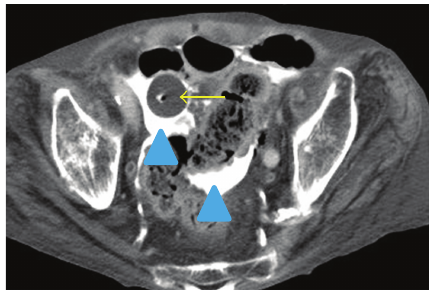
Figure 2: Contrast-enhanced computed tomography after transurethral perfusion of contrast medium demonstrated extravasation of the contrast material into the peritoneal cavity ( 󳵳 ). In addition, the Foley catheter balloon (arrowhead) was located within the peritoneal cavity through the urinary bladder.